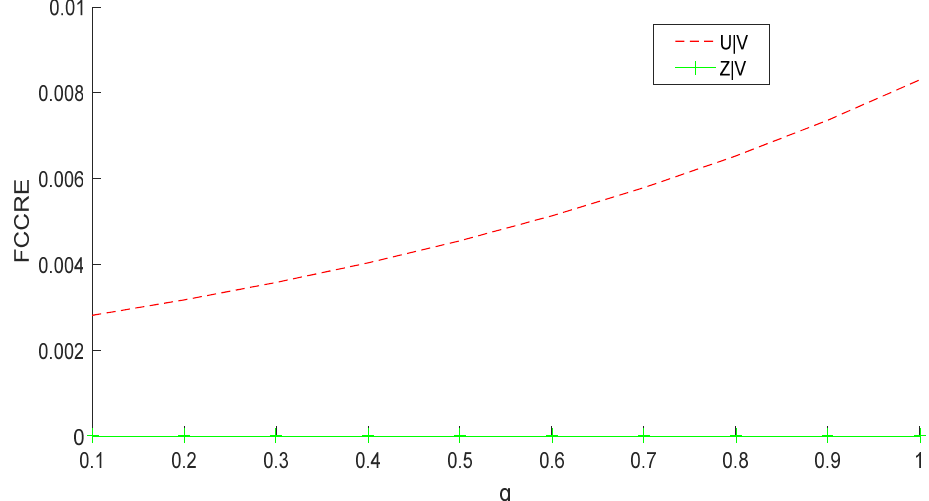
( ) | Z V ε . Figure 9. The fractional conditional cumulative residual entropy of ε q ( U | V ) and ε q ( Z | V ) q